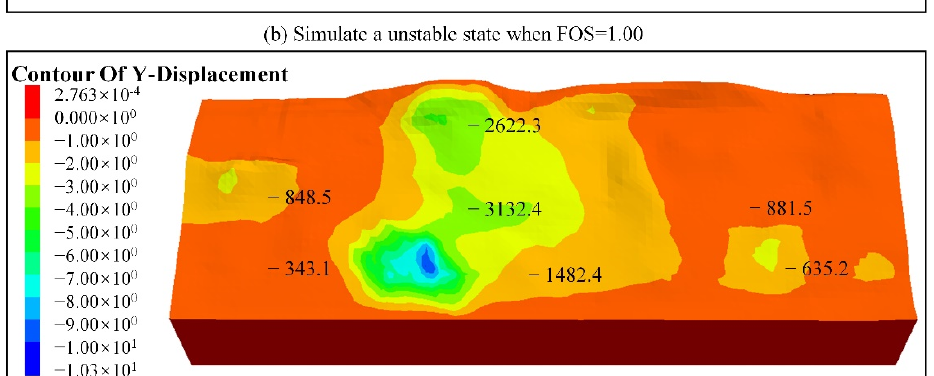
Table 5. Two sets of displacement warning thresholds